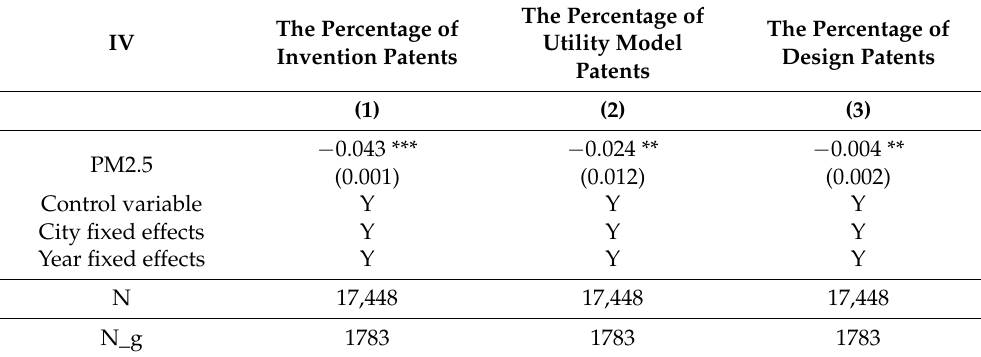
Table 7. Robustness test